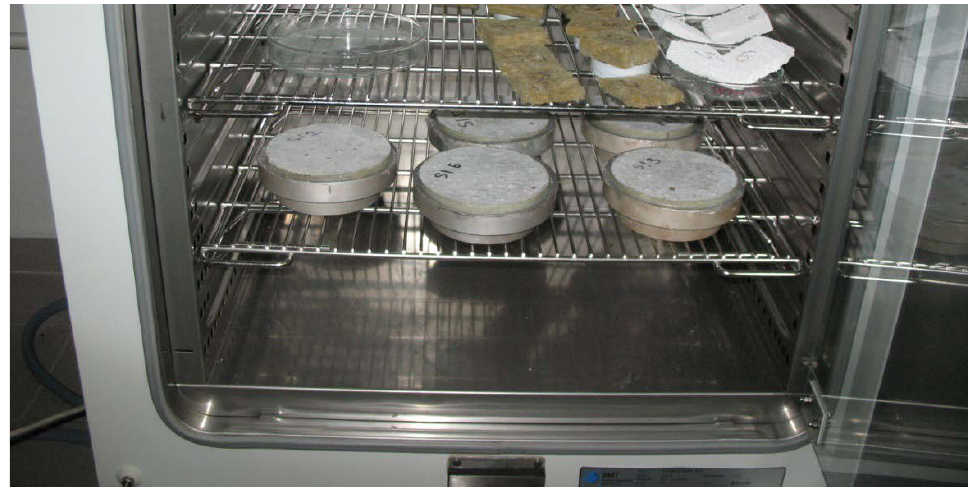
Figure 4. Cup method—placement of cups with samples in a climatic chamber with controlled environment.